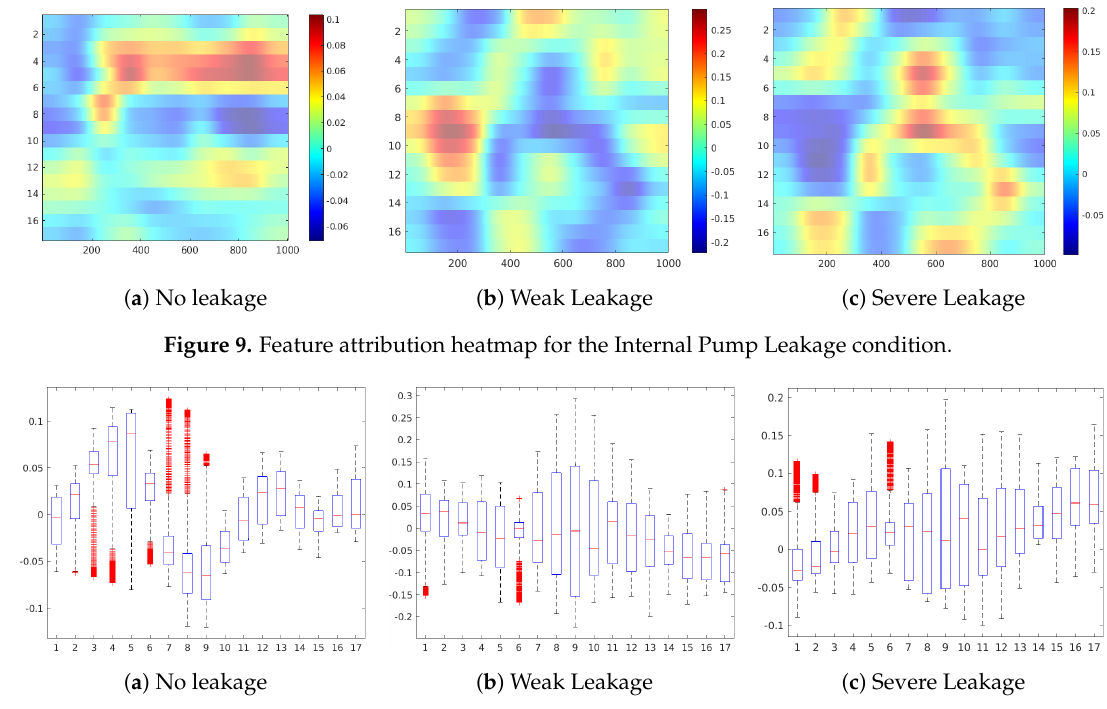
Figure 10. Boxplot of the sensor contributions for the Internal Pump Leakage